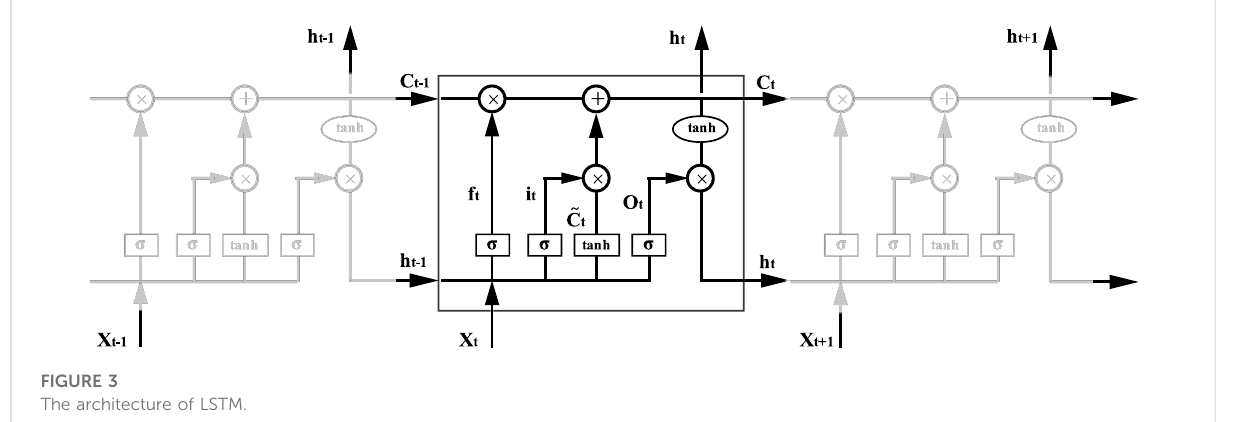
FIGURE 3 The architecture of LSTM.